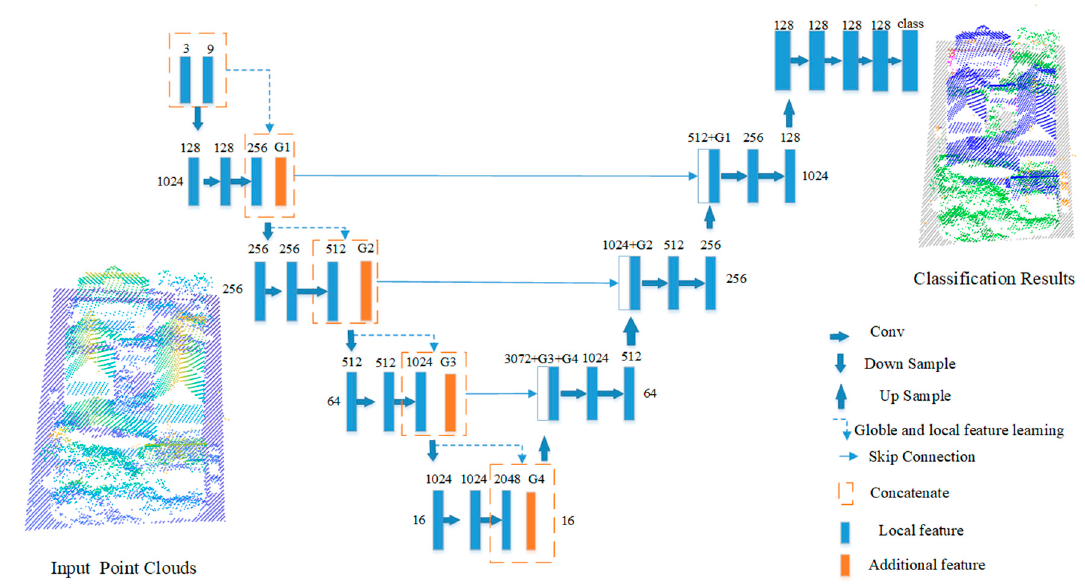
Figure 3. Illustration of proposed network architecture. The network adds additional features to local features. The input point clouds on the left are colored by elevation, and the output is the classification